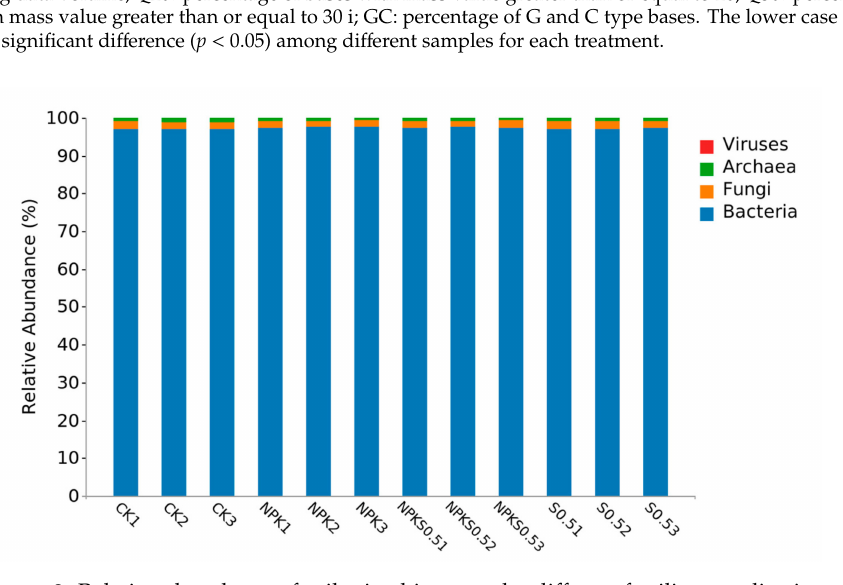
Figure 2. Relative abundance of soil microbiome under di ff erent fertilizer